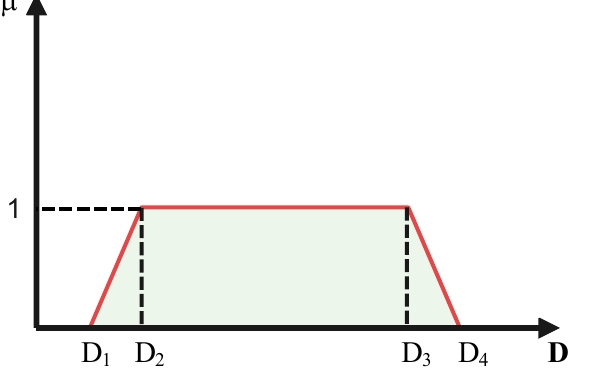
Figure 2. The trapezoidal possibility distribution of fuzzy parameter D